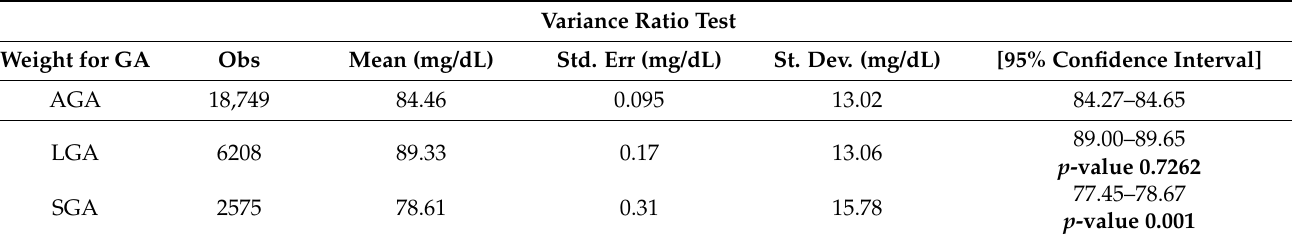
Table 7. Variance ratio test based on nutrition strategy AGA, appropriate for gestational age; SGA, small for gestational age; LGA, large for gestational age.